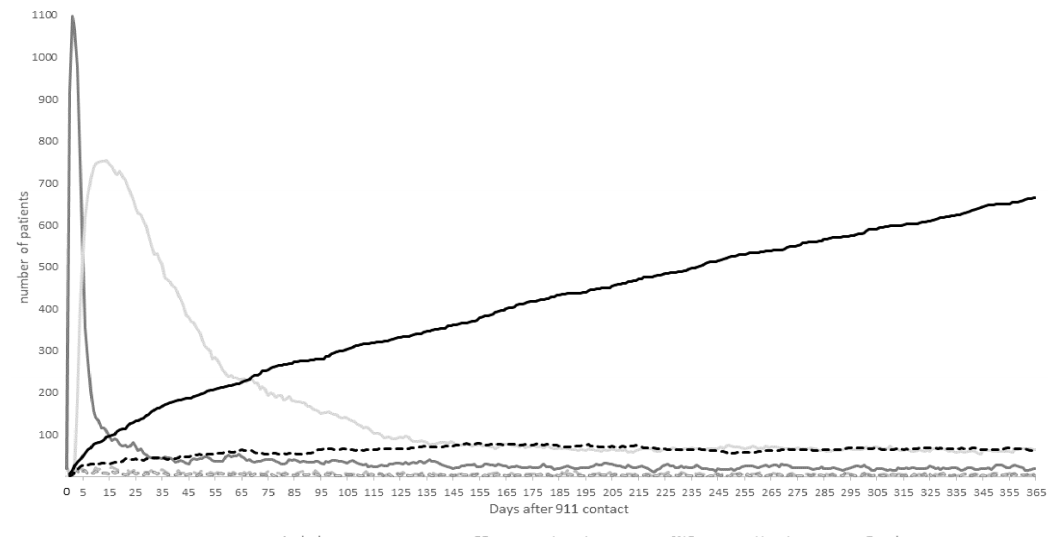
Figure 2. Changes in healthcare use and mortality to one year among community-dwelling older adults requiring ambulance transport after a fall (N = 3159).